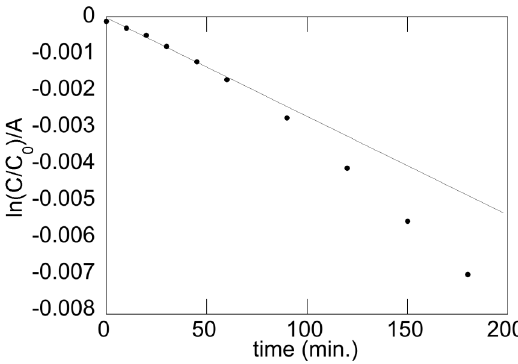
Figure 4. Semi-log plot of rhoB concentration with time. Within the first 60 min of irradiation, first-order reaction kinetics fit the observed degradation as indicated by the solid line. However, the change in overall reaction order is apparent after the first 60